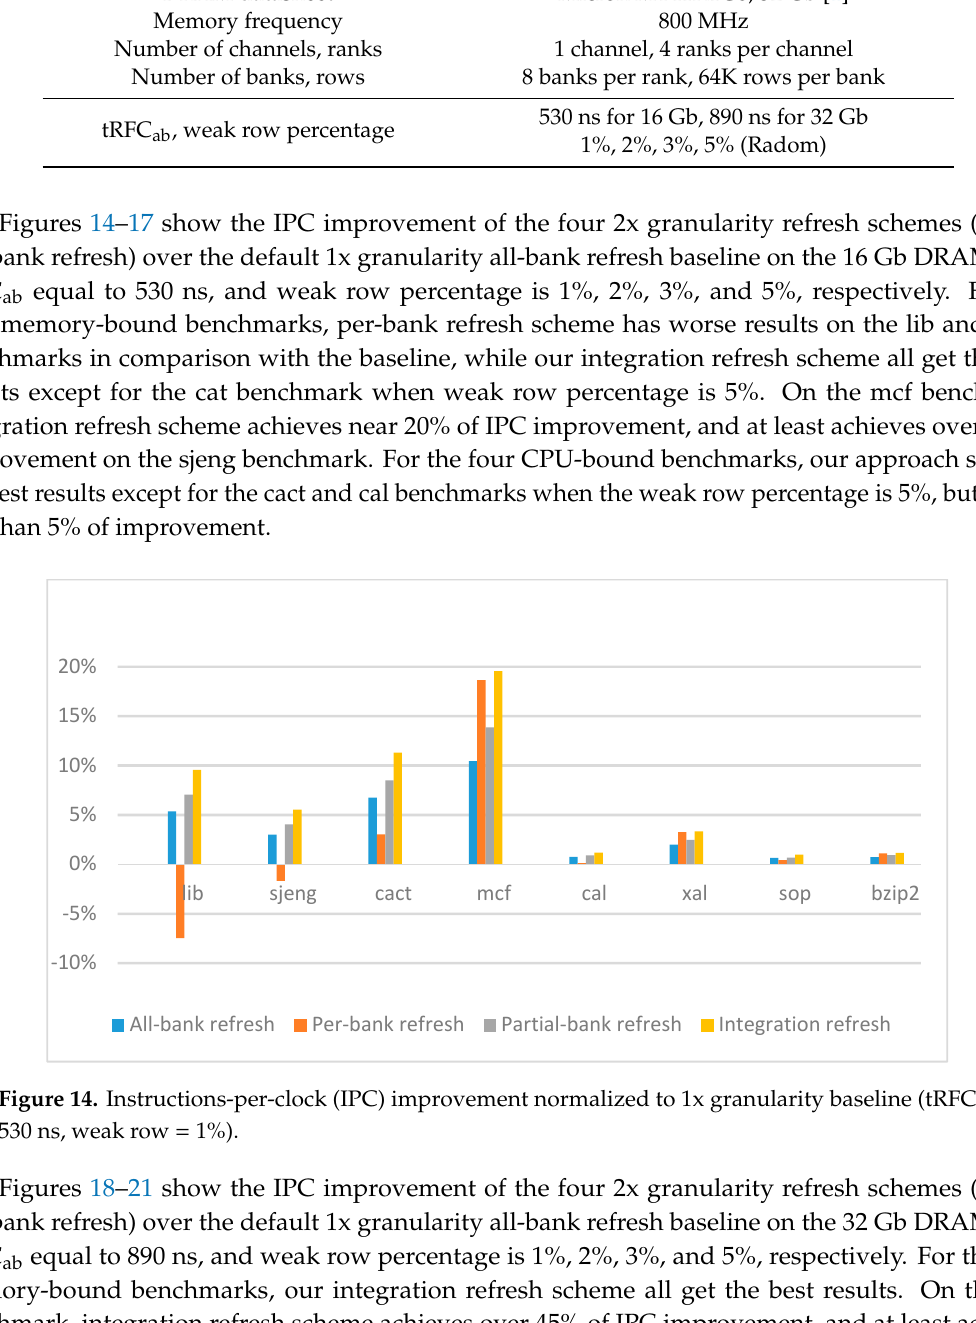
Figure 15. IPC improvement normalized to 1x granularity baseline (tRFC = 530 ns, weak row = 2%). Figure 16. IPC improvement normalized to 1x granularity baseline (tRFC = 530 ns, weak row = 3%).